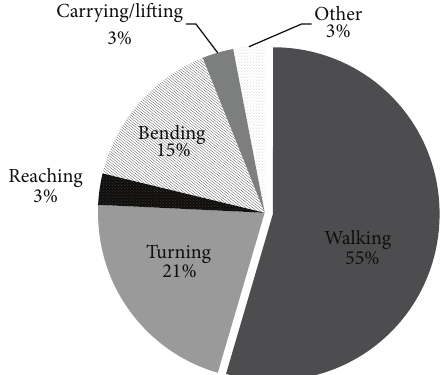
Figure 1: Distribution of activities undertaken prior to most recent fall.